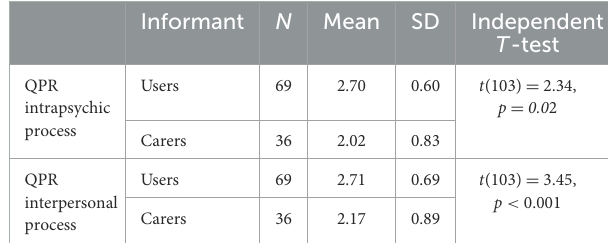
TABLE 1 The mean scores and standard deviation of the two scales of Questionnaire of Personal Recovery (QPR) for users ( n = 69) and carers ( n = 36).